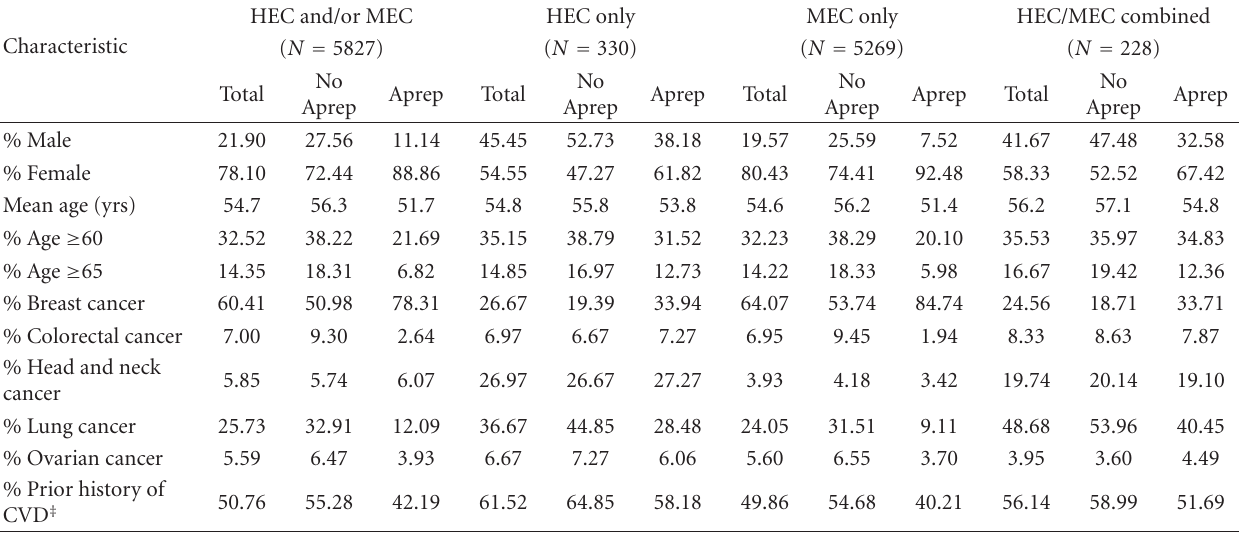
Table 1: Characteristics of 5827 patients with select ∗ cancers and ≤ 4 cycles of HEC, MEC, or HEC/MEC combined, 2005–2007 IMPACT National Benchmark Database (OptumInsight, Eden Prairie,